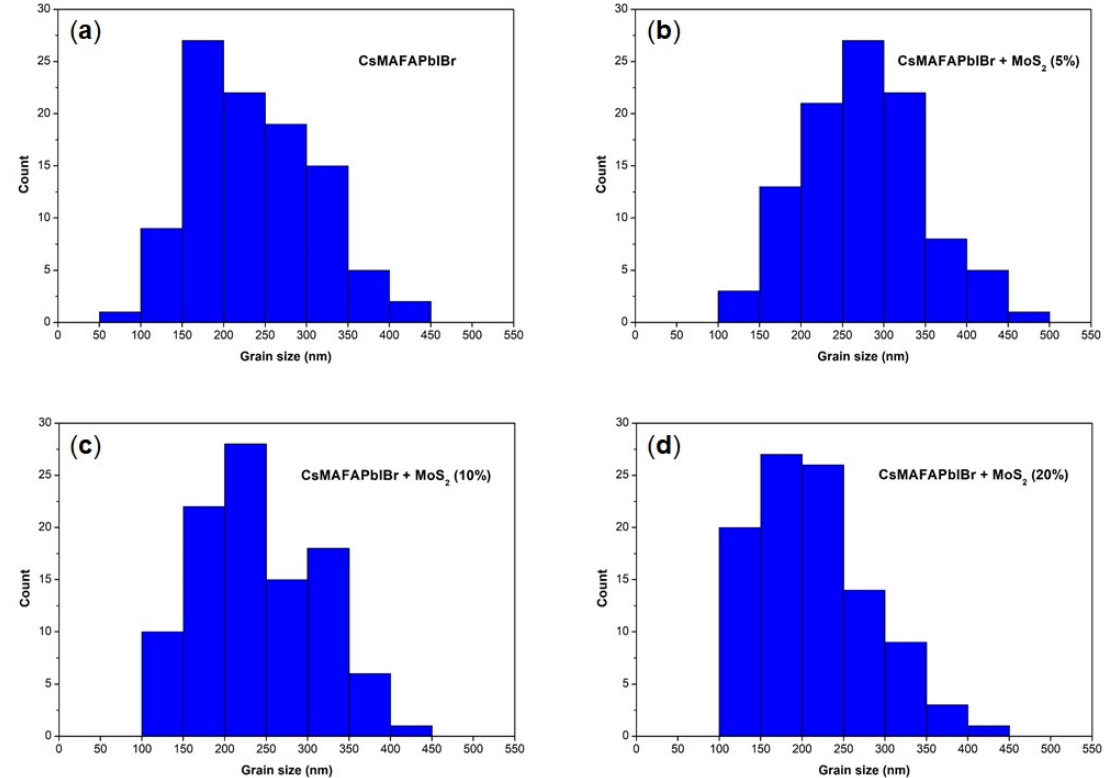
Figure 6. Particle size distribution histograms of the as-prepared CsMAFAPbIBr perovskite films, with and without MoS 2 additive: ( a ) CsMAFAPbIBr; ( b ) CsMAFAPbIBr + MoS 2 (5%); ( c ) CsMAFAPbIBr + MoS 2 (10%); ( d ) CsMAFAPbIBr + MoS 2 (20%). Table 3. Statistical analysis for the CsMAFAPbIBr grain size, with and without MoS 2 additive.